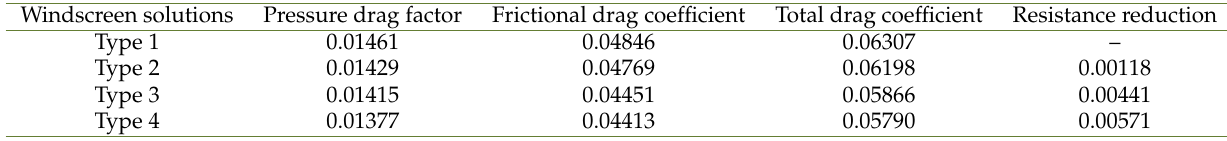
Table 3. Comparison of head vehicle drag coefficients.